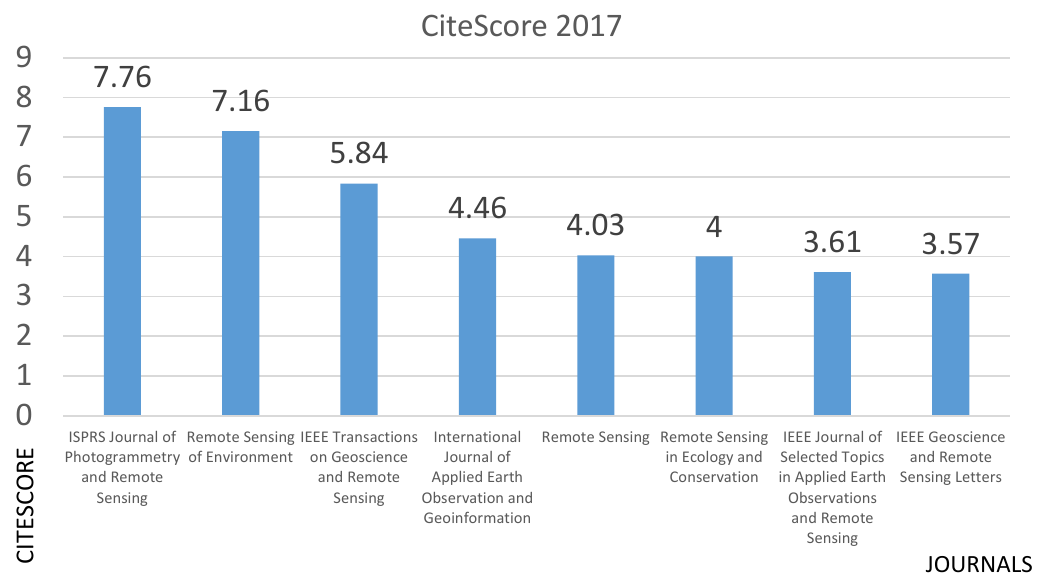
Figure 5. Total number of online readership has reached over 4 million in year 2018 at the time of writing this article (30 October 2018). We excluded these five journals (IEEE Geoscience and Remote Sensing Magazine, IEEE Transactions on Geoscience and Remote Sensing, IEEE Geoscience and Remote Sensing Letters, IEEE Journal of Selected Topics in Applied Earth Observations and Remote Sensing, Photogrammetric Record) with only publication time and no acceptance time. We can see the publication speed of 16